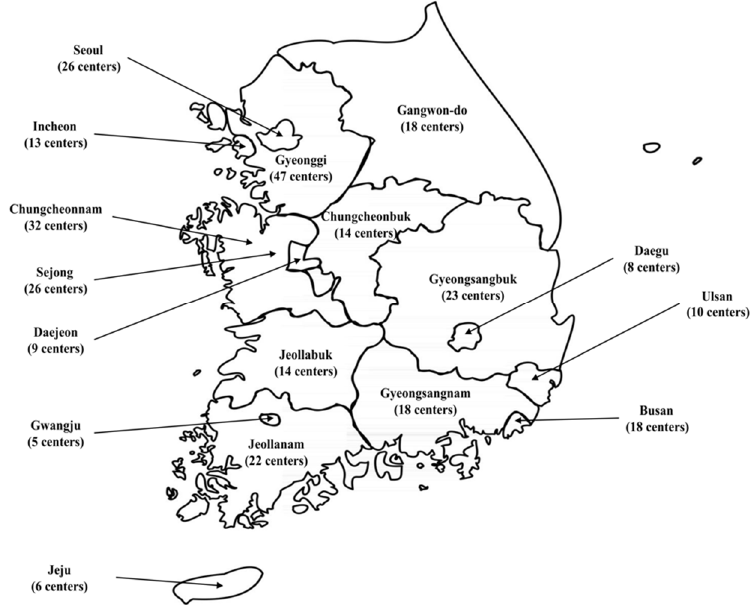
Figure 1. Graphical information on long-term care centers in the Korean nation.